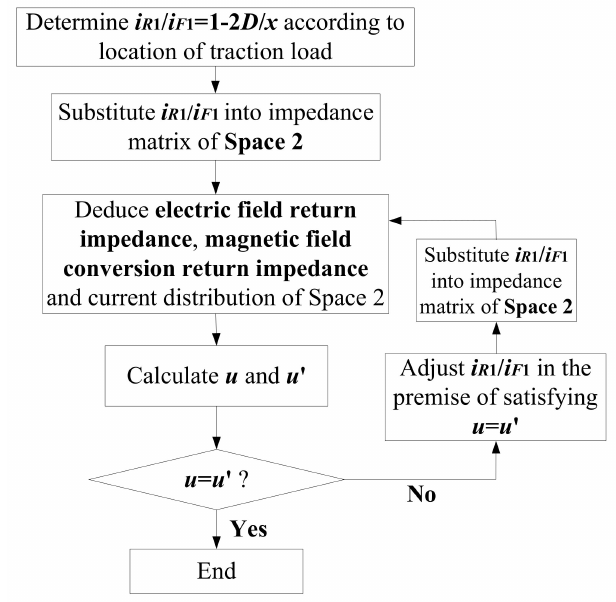
Figure 5. Flowchart of the iterative calculation aimed at satisfying the constraint condition in Equation